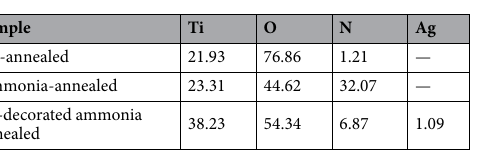
Sample Ti O N Ag Air-annealed —